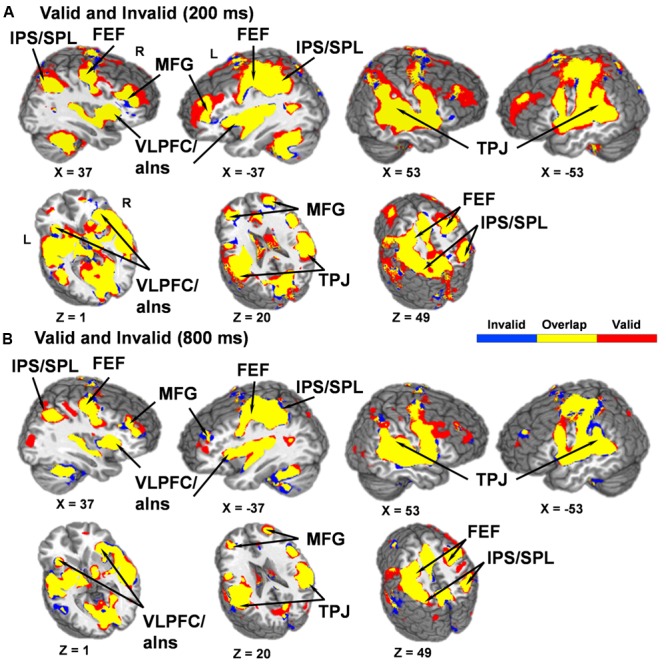
Results from post hoc t-tests comparing activation during both valid and invalid trials relative to baseline at the 200 (A) and 800 (B) ms SOAs. Areas significantly activated for invalid trials are displayed in blue color and areas significantly activated for valid trials are displayed in red color, with the overlap of activation for both invalid and valid trials displayed in yellow (p < 0.001). Locations of the sagittal (X) and axial (Z) slices are given according to the Talairach atlas for the left (L) and right (R) hemispheres. A qualitative examination of the functional maps indicates that valid and invalid trials at both SOAs activated key structures within the dorsal [intraparietal sulcus (IPS), superior parietal lobule (SPL), and frontal eye fields (FEF)] and ventral [temporoparietal junction (TPJ), ventrolateral prefrontal cortex/anterior insula (VLPFC/aIns) and the middle frontal gyrus (MFG)] networks.